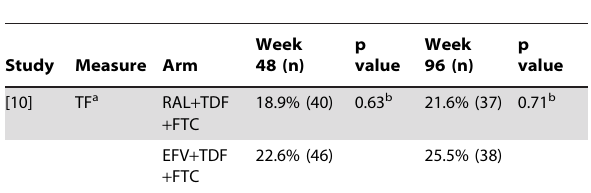
Table 16. Change from baseline in trunk fat (TF) on DEXA scan, and visceral adipose tissue (VAT) on CT scan: raltegravir versus efavirenz.